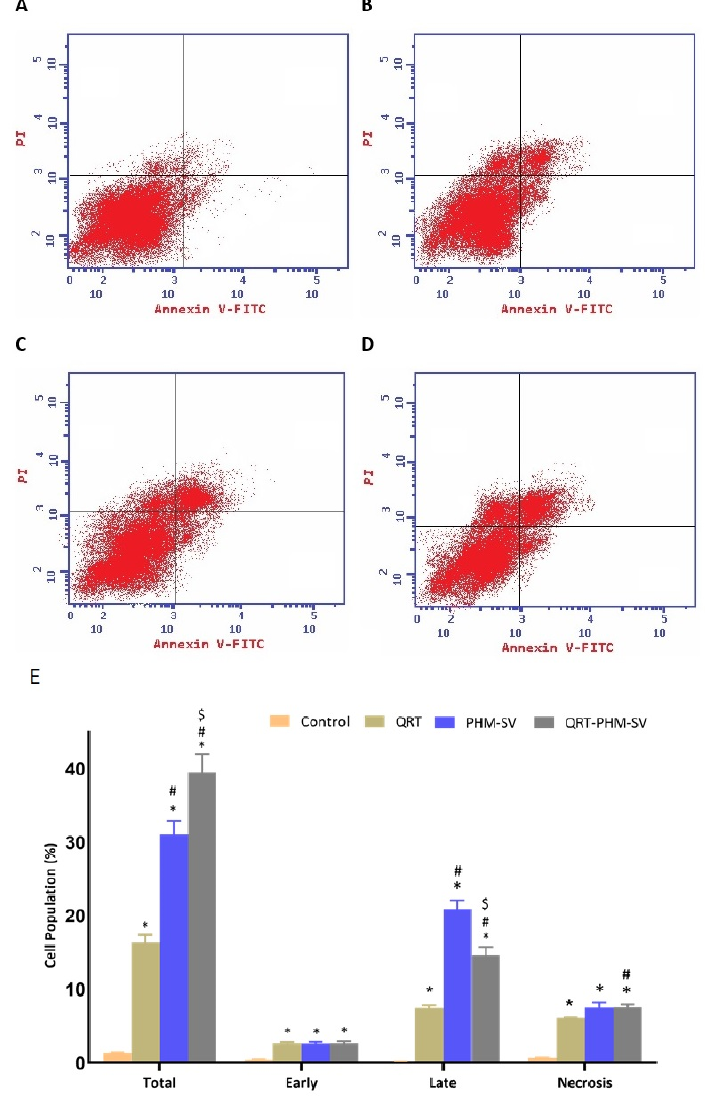
Figure 8. Assessment of MCF-7 cell death in control ( A ); QRT ( B ); PHM-SV ( C ); and QRT-PHM-SV- treated cells ( D ); and the percentages of cells early, late, and total cell death ( E ) following annexin V staining. * Significantly different from control at p < 0.05; # significantly different from QRT at p < 0.05; $ Significantly different from PHM-SV at p < 0.05.